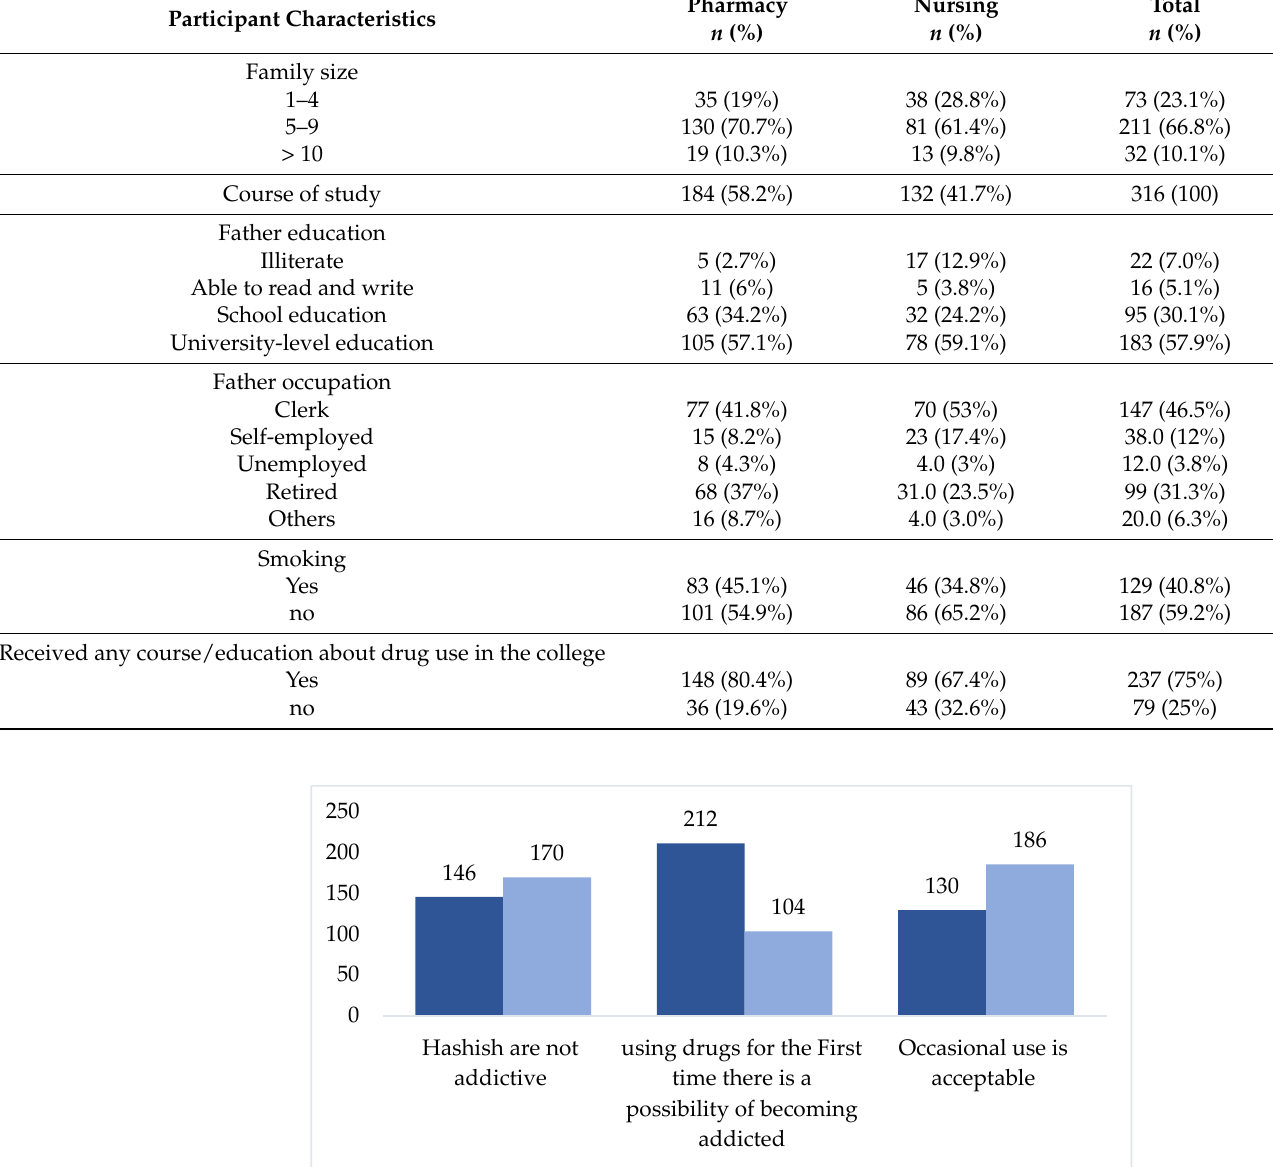
Table 1. Demographics of the participants ( n = 316).